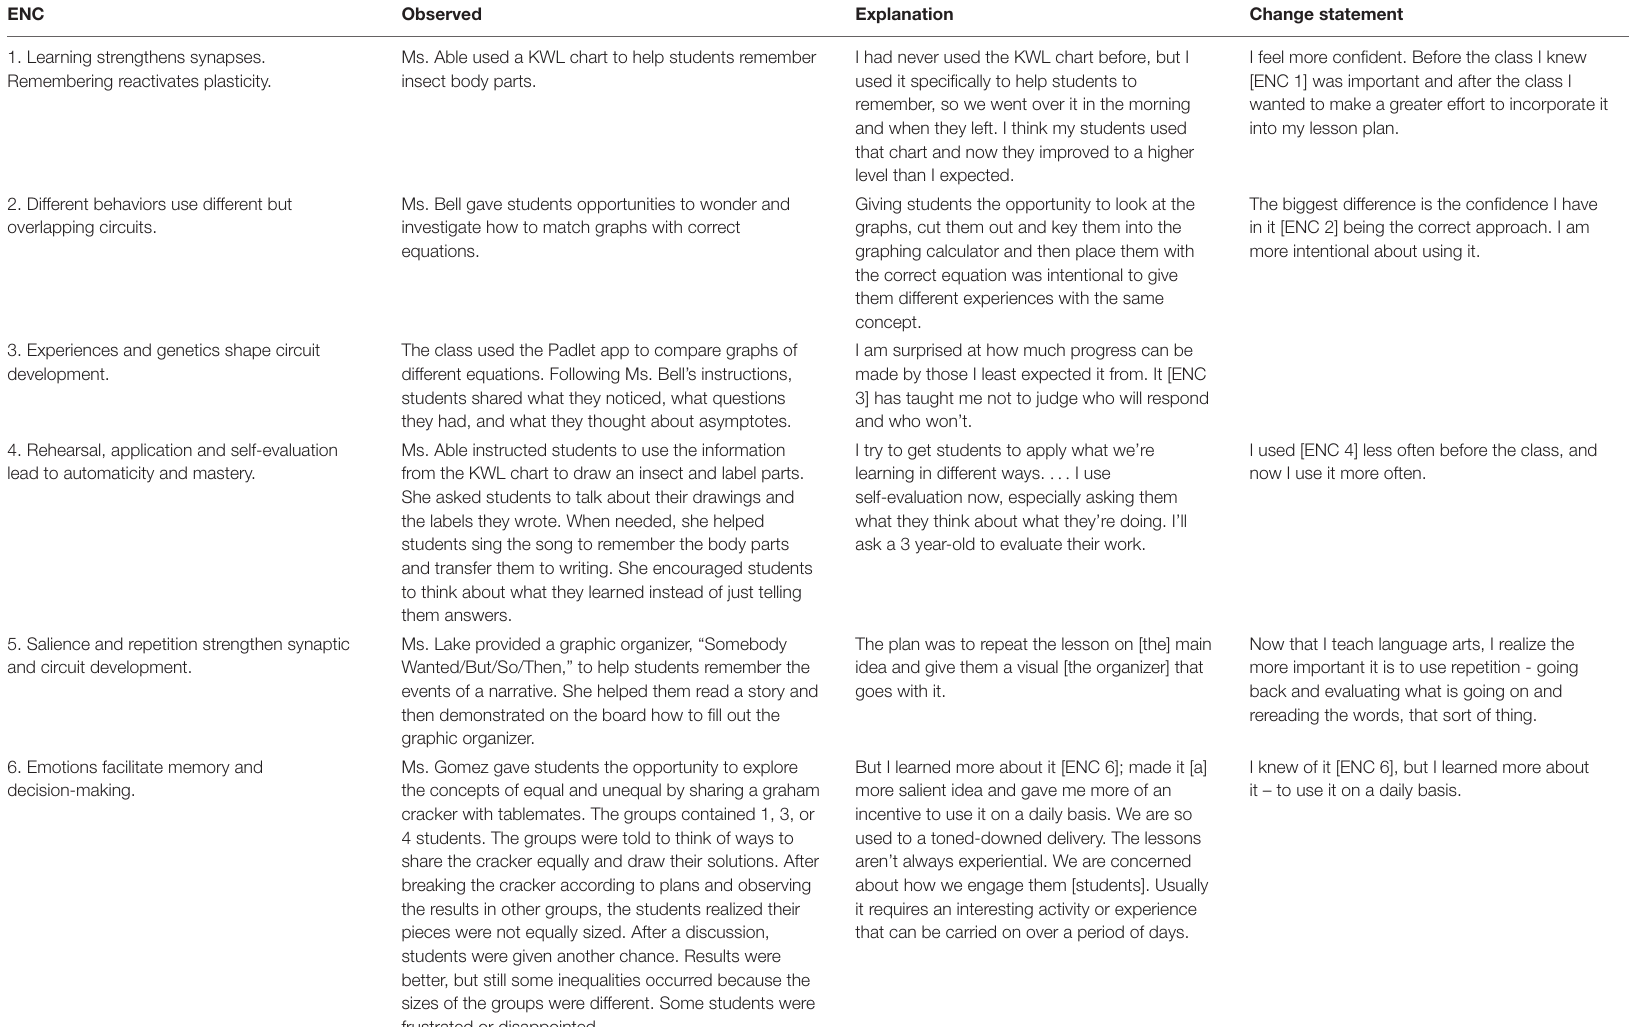
TABLE 2 | Examples of how teachers applied the educational neuroscience concepts. ENC Observed Explanation Change